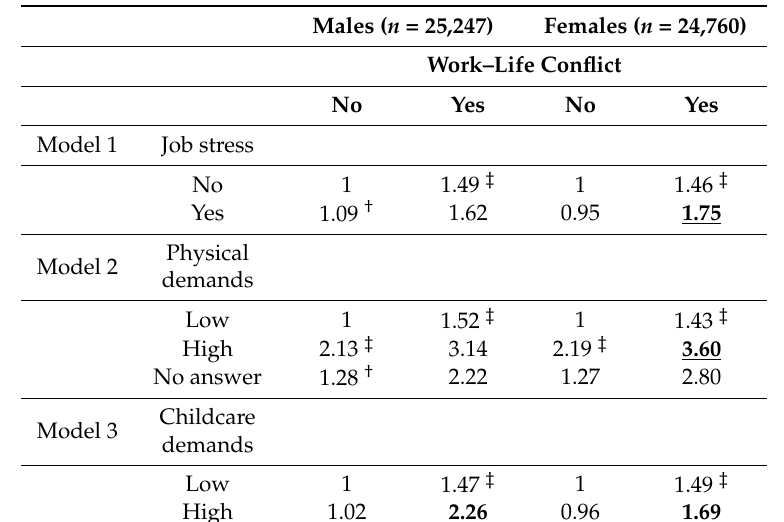
Table 4. Odds ratios for associations of MSDs and WLC with work and family demands with significant interaction